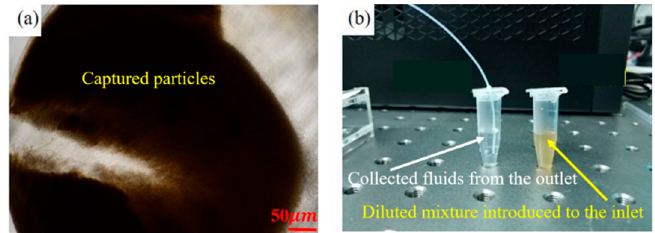
Figure 7. After 50 min of manipulation, ( a ) the capture performance was considerably enhanced and ( b ) the collected fluids from the outlet were clear compared with the diluted mixture introduced into the inlet.